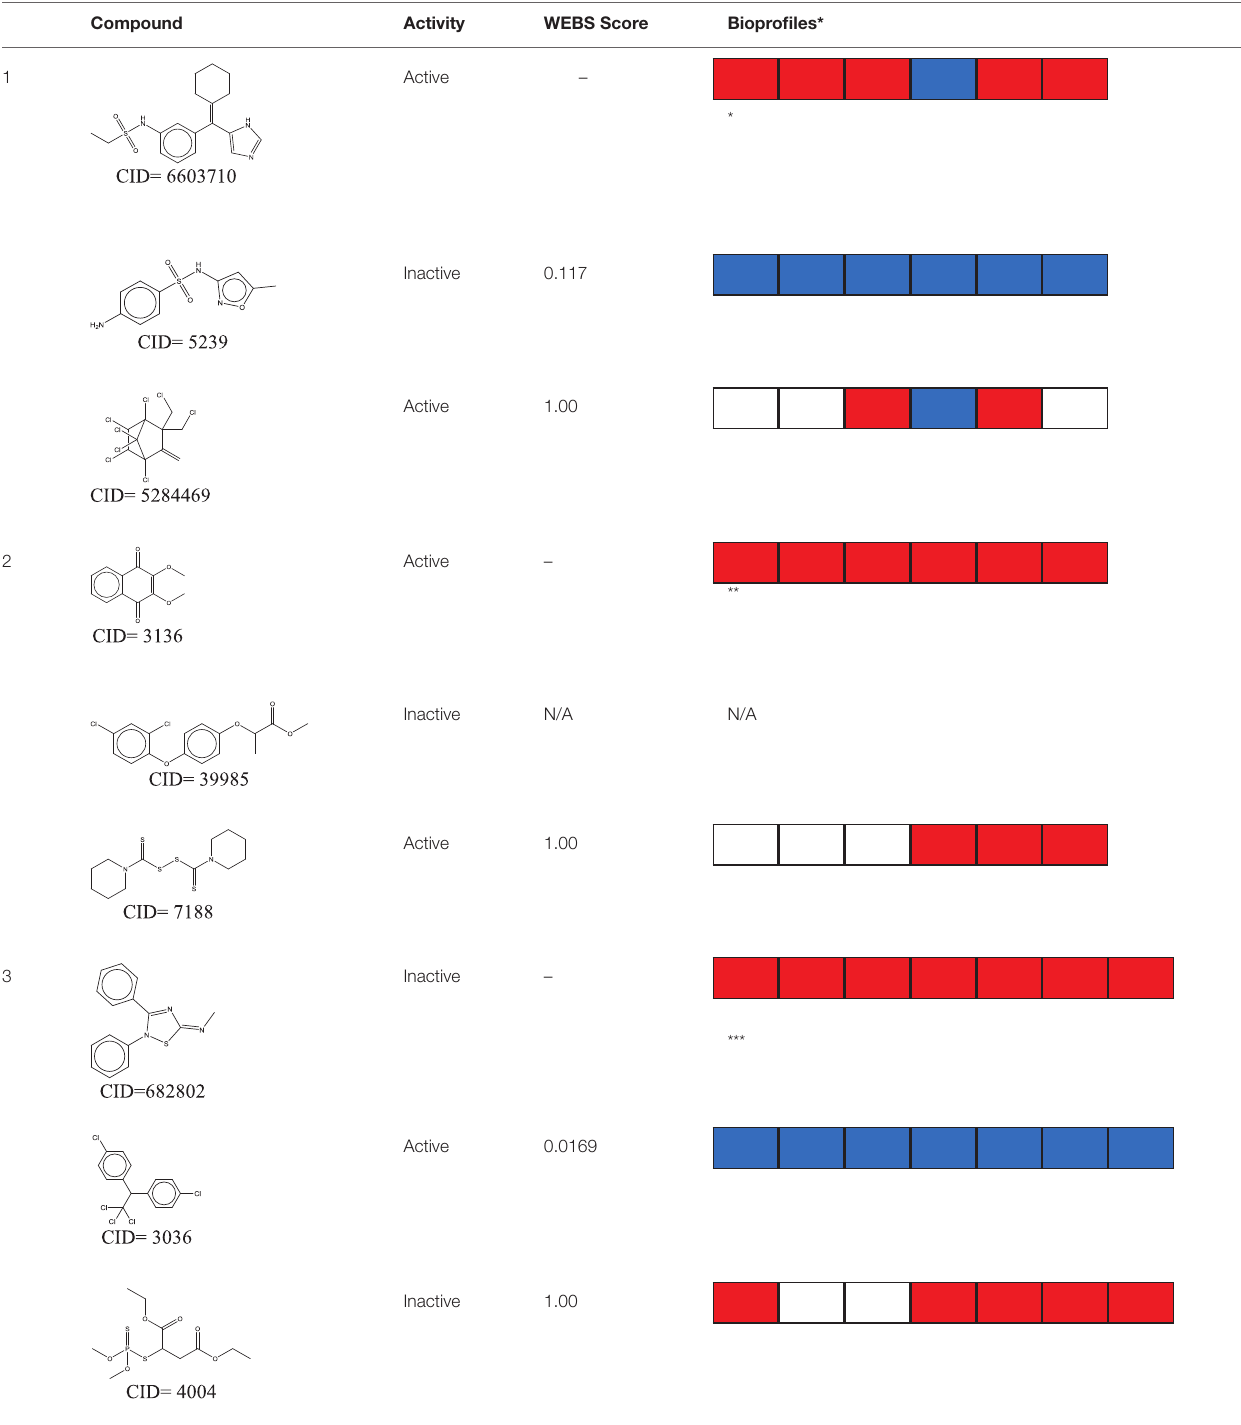
TABLE 2 | Three test set compounds (the first compound in each group) with their chemical nearest neighbor (the second compound) and biological nearest neighbor (the third compound).